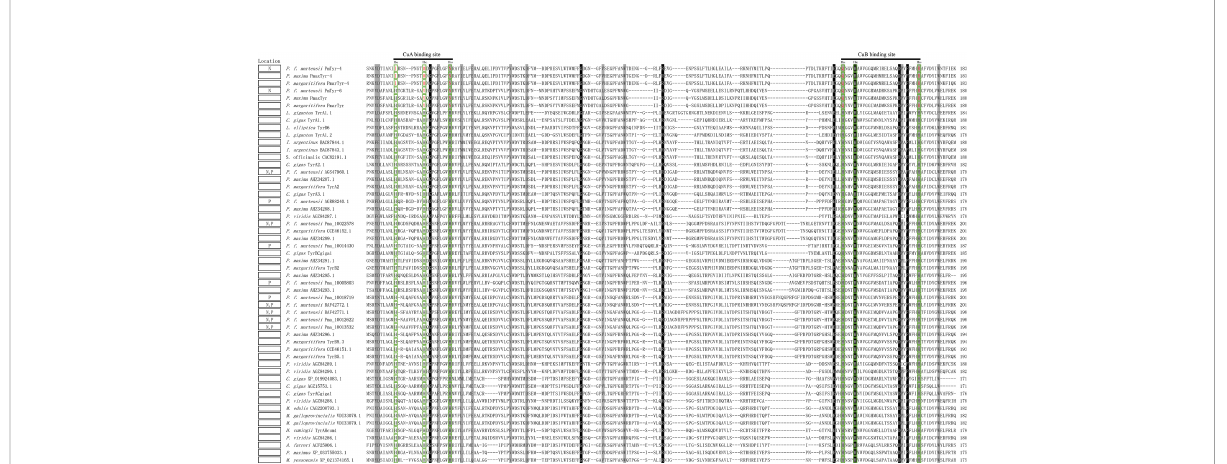
FIGURE 1 Multiple-sequence alignment of members of the tyrosinase family in 15 mollusks. The black background indicates the conserved amino acid; the gray one indicates amino acid with strong similarity. The green box indicates the sites of six conserved histidine residues. Amino acids marked in red in a green box indicate mutated amino acids. N, nacre layer; P, prismatic layer. The full names of the species corresponding with the abbreviations are listed in Table S2 (Supplementary Table